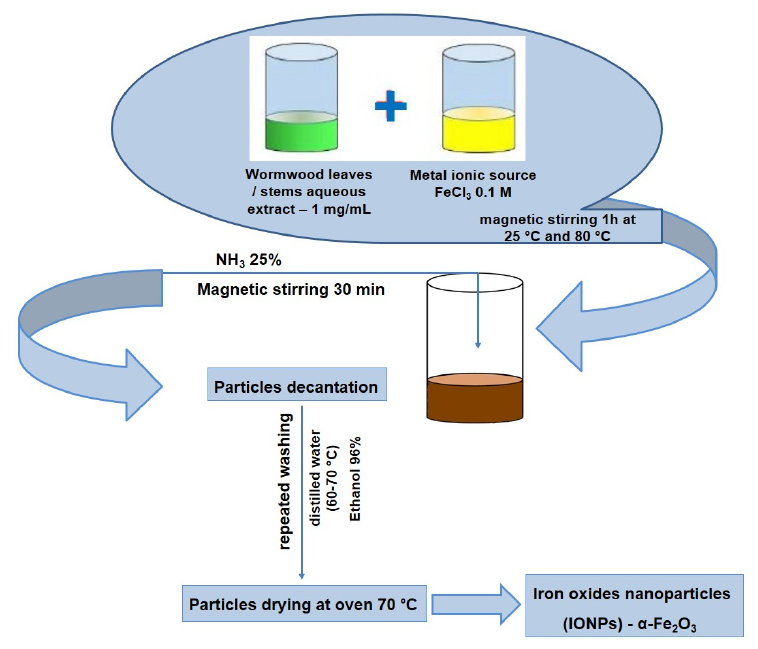
Figure 1. Schematic protocol of iron oxide nanoparticles synthesis by green method.